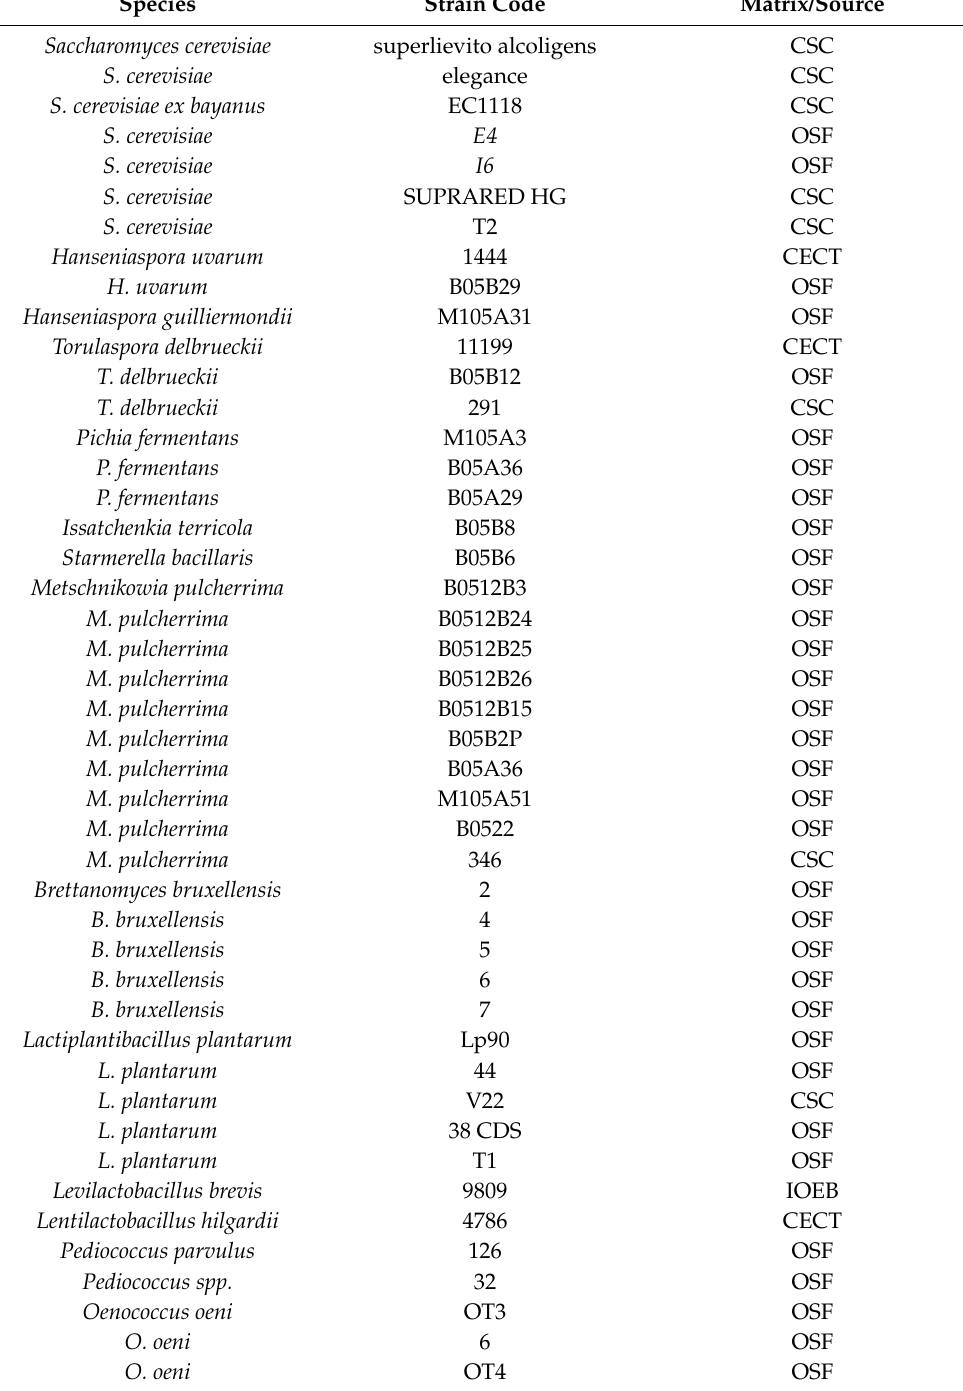
Table 1. List of microorganisms of enological interest used in this